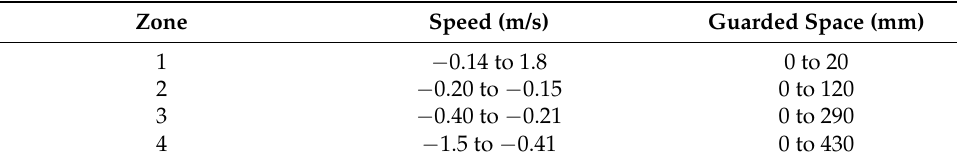
Table 3. Robot speed zones (backward)